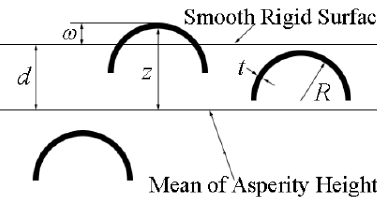
Figure 7. A model of a coated rough surface in contact with a smooth rigid surface, taken from [49].